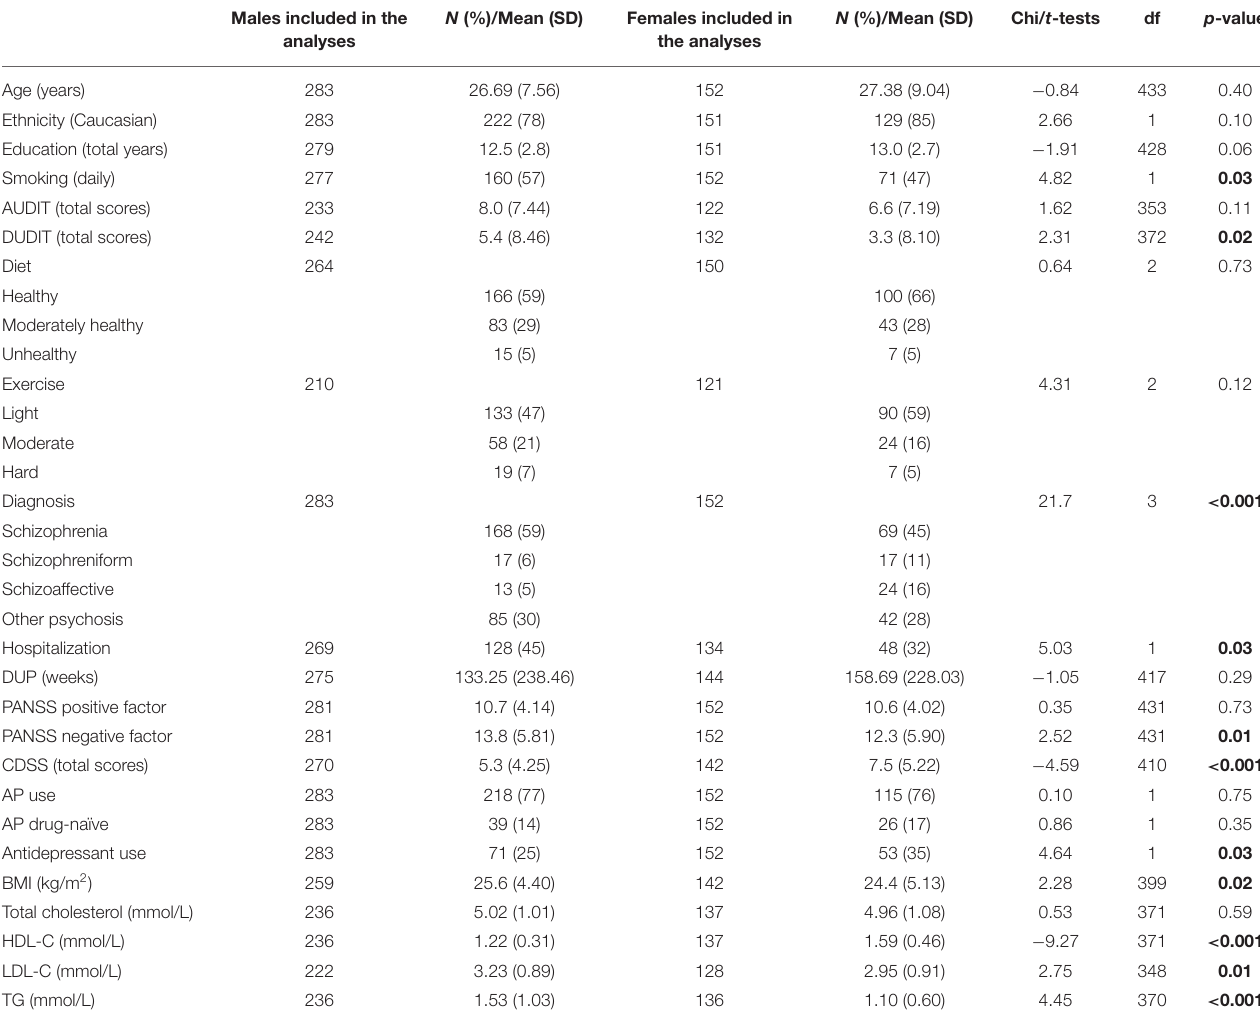
TABLE 1 | Group comparison of demographic, lifestyle, illness, and metabolic variables. N (%)/Mean (SD) Females included in N (%)/Mean (SD) Chi/ t -tests df p Males included in the analyses the analyses